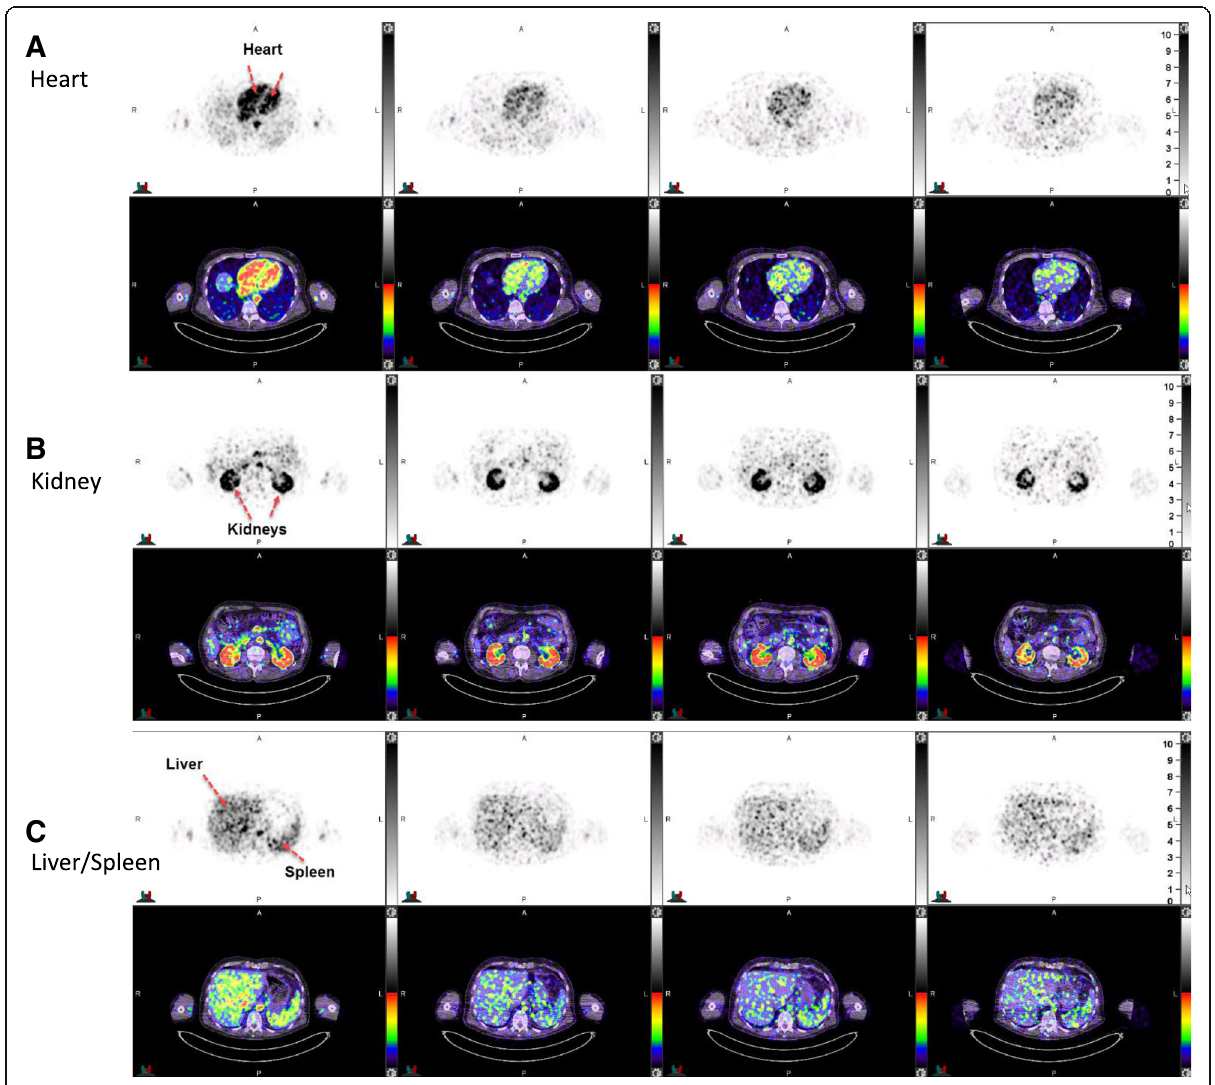
Fig. 2 Transaxial images (top PET, bottom PET/CT fused images) across the a heart, b kidneys, and c liver/spleen from the same subject 135 presented in Fig. 1. Times post dose 7, 79, 120, and 168 h post dose. Additional transaxial images for additional subjects 105 and 127 are provided in the Additional file 1: Figures S3 and